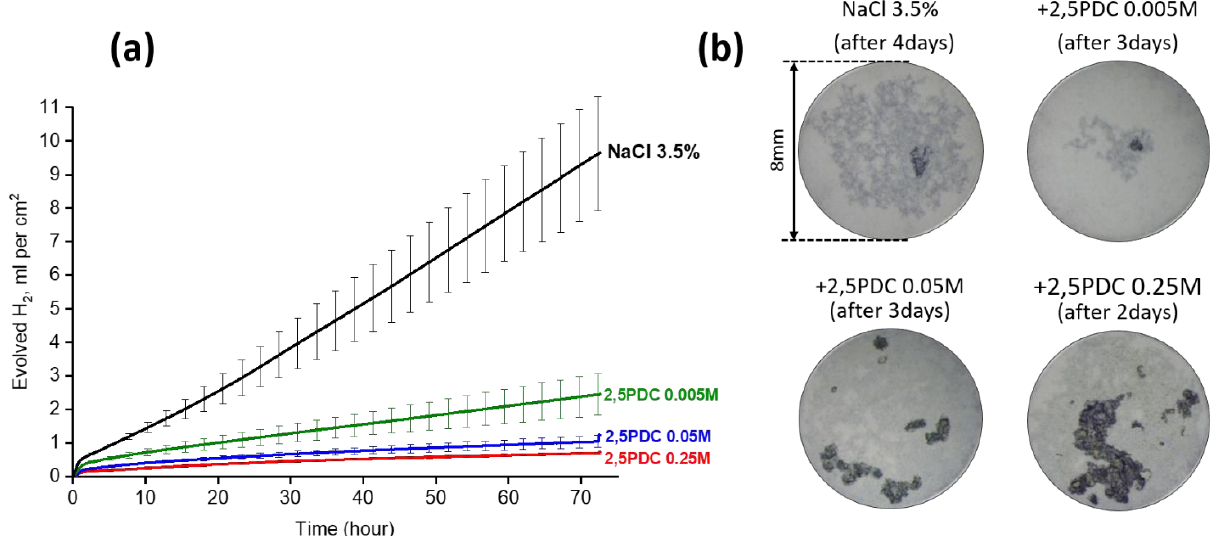
Figure 27. ( a ) H 2 evolved during immersion of the AZ21 sample in 3.5wt.% NaCl solution containing different concentrations of 2,5PDC. ( b ) The surface appearance of PEO-coated AZ21 after the failure (duration is specified in each case) in 3.5 wt.% NaCl solution containing different concentration of 2,5PDC. Adapted [159] with permission from Elsevier.